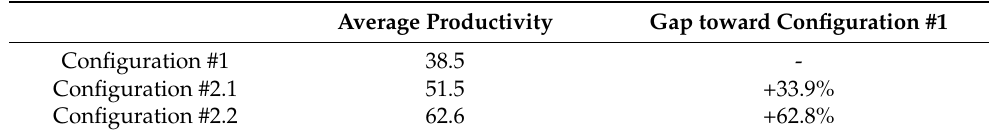
Table 3. Average productivity [pcs/h].